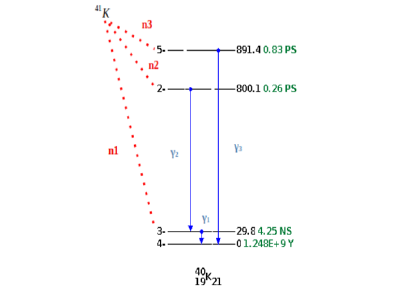
Figure 1. Energetically allowed excited states of the residual nucleus along with the three measured gamma rays .